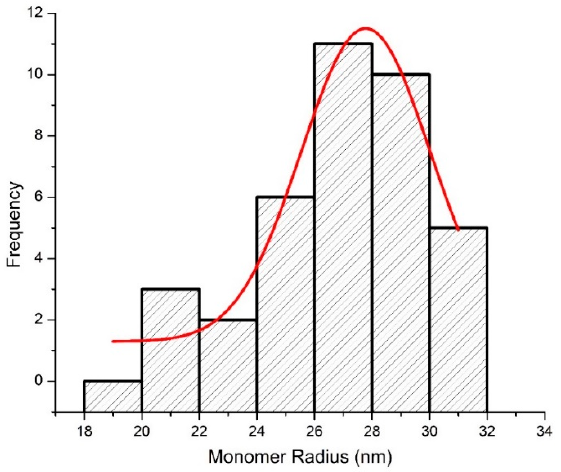
Figure 2. TEM analysis of monomer radius of aggregates generated from biomass burning of eucalyptus fuel.